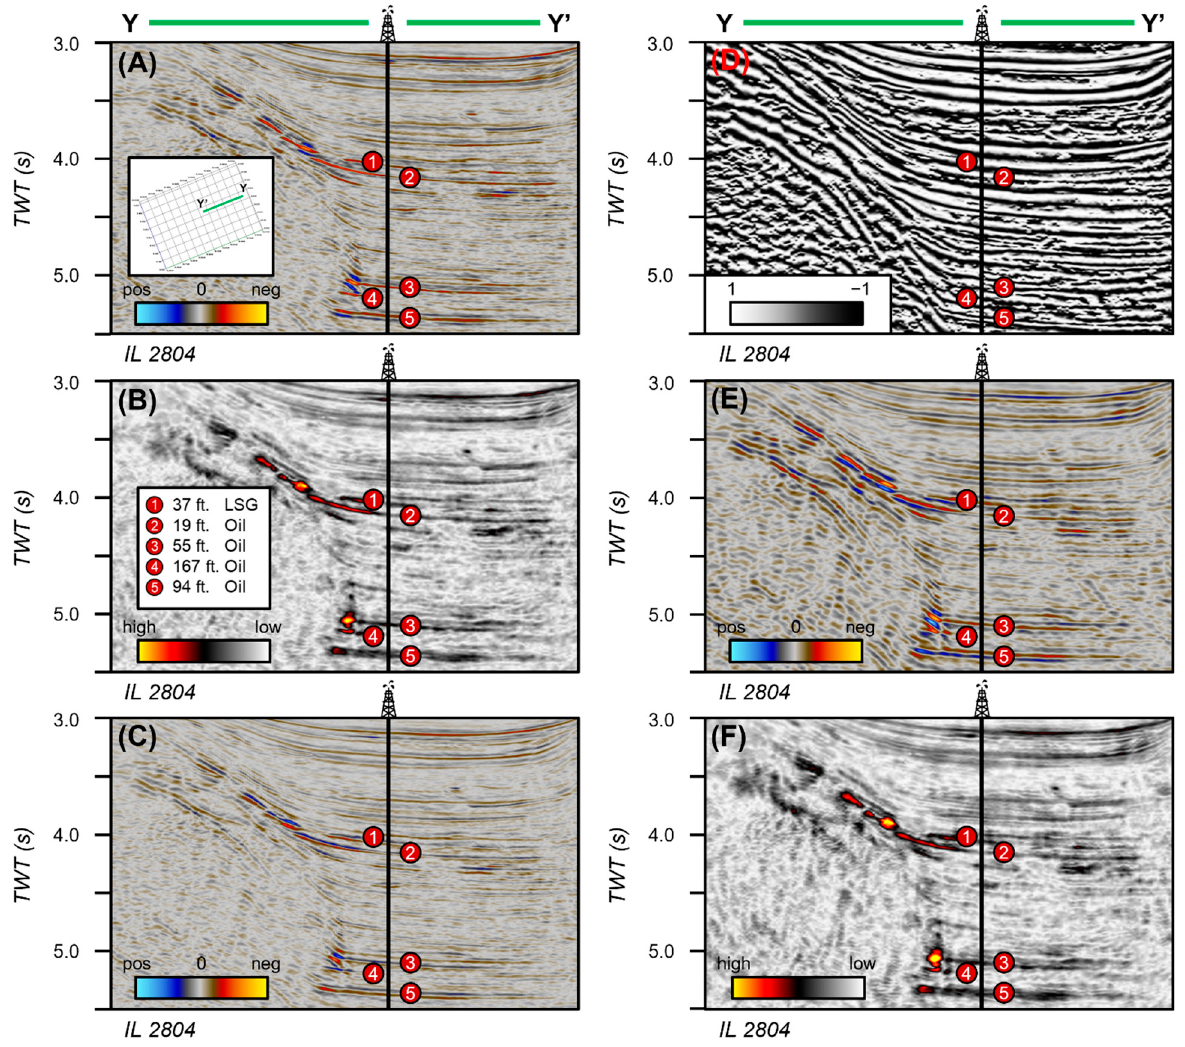
Figure 10. All the attributes from the KK/LA PCA that were used as an input into the Ursa SOM where ( A ) is the full-stack amplitude, ( B ) is the envelope, ( C ) is the Hilbert, ( D ) is the cosine of instantaneous phase, ( E ) is the relative acoustic impedance, and ( F ) is the sweetness. The LSG-prone interval is shown by Circle 1, whereas the hydrocarbon intervals is shown by Circles 2–5. LSG and hydrocarbon intervals modified after Hilterman [2].